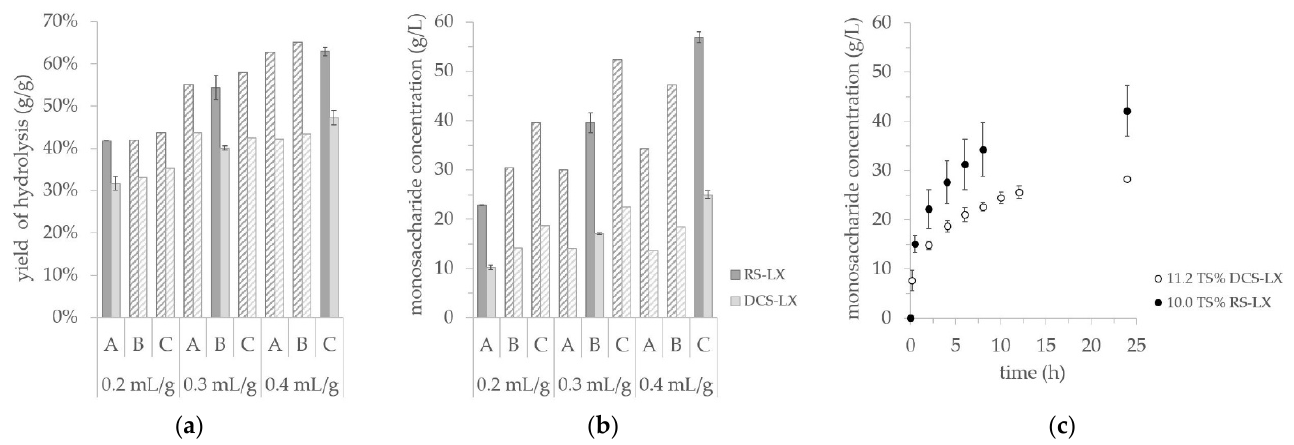
Figure 2. Enzymatic hydrolysis: ( a ) yield of hydrolysis and ( b ) monosaccharide concentration of shaking flask experiments with results from RS-LX and DCS-LX at 50 °C and pH 5 after 24 h duration: (A, B, C = 6.8, 9.0, 11.2 TS% load, enzyme concentration = 0.2, 0.3 and 0.4 mL CCT2 g − 1 cellulose; crosshatching denotes experiments that were run without duplicates); ( c ) monosaccharide concentration of scale-up experiments in 2 L-benchtop reactors at 50 °C and pH 5 (0.3 mL CCT2 g − 1 cellulose was added to the substrate DCS-LX and 0.4 mL g − 1 to RS-LX, respectively).